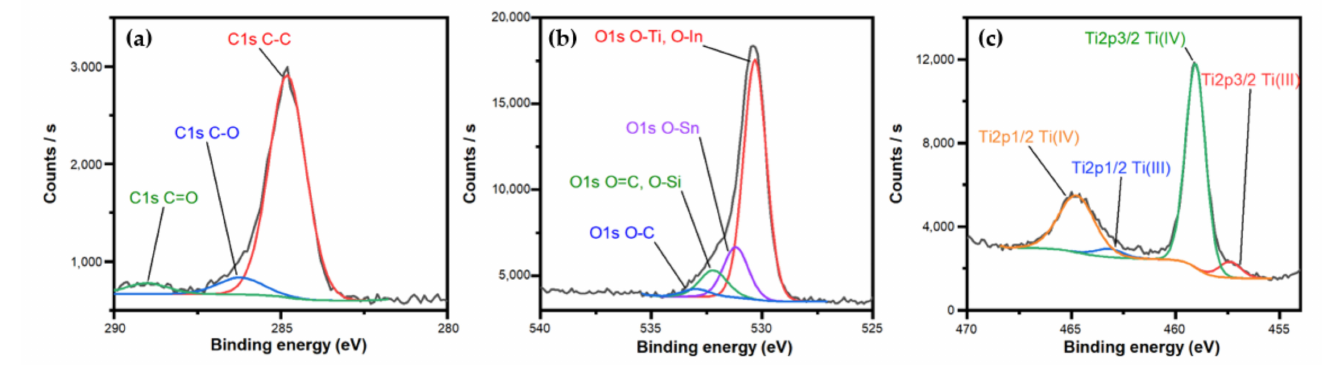
Figure 5. XPS results after deconvolution: ( a ) C1s scan; ( b ) O1s scan; ( c ) Ti2p scan.